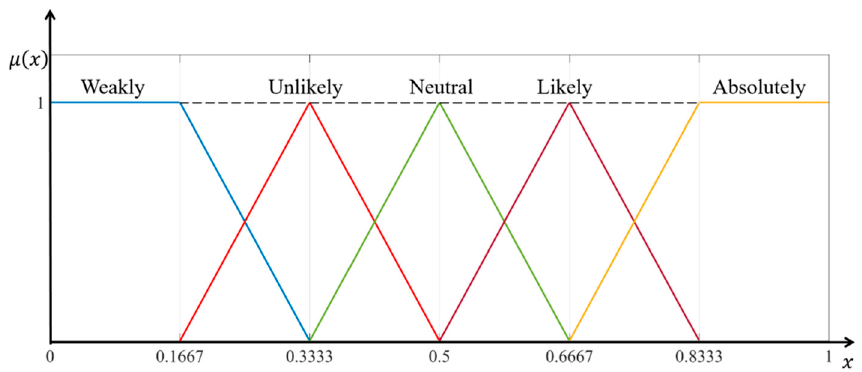
Figure 9. Five-scale self-confidence linguistic terms.